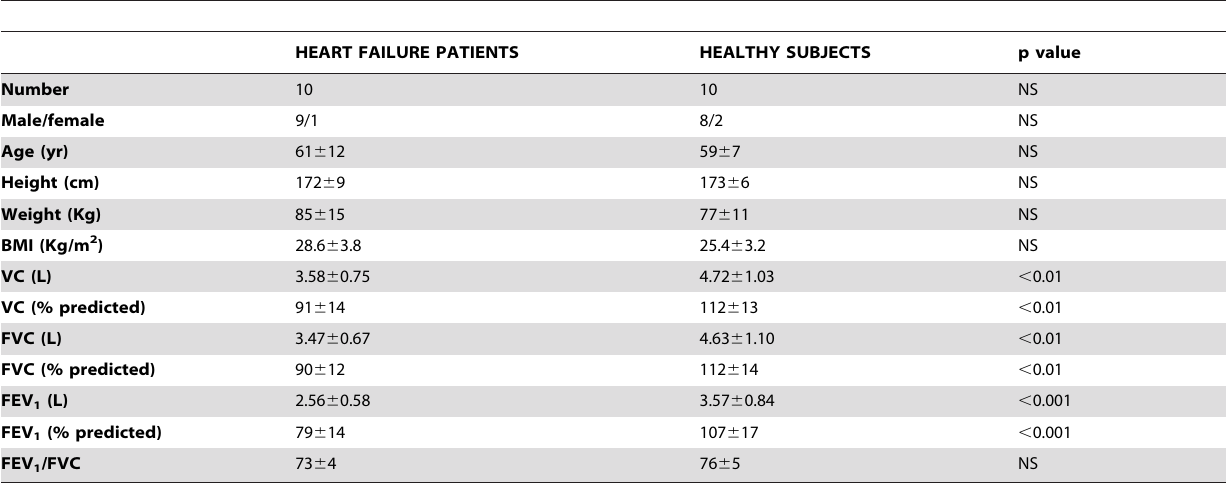
Table 1. Main anthropometric characteristics, demographical and pulmonary function data of heart failure patients and healthy subjects enrolled in the study.